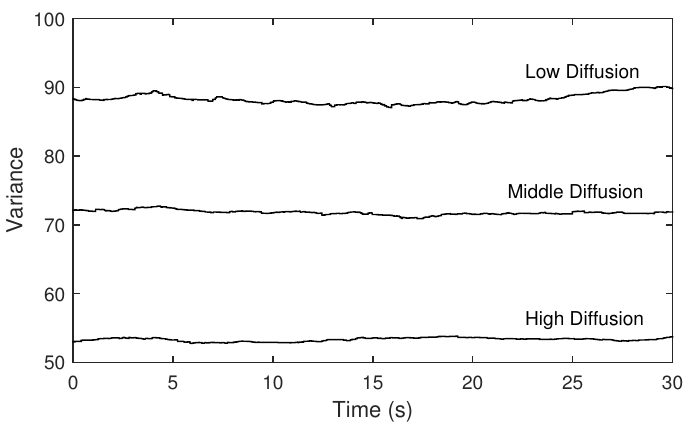
Figure 17. Variances of magnitudes of the measured transfer functions when the diffusion parameter is set to low, middle and